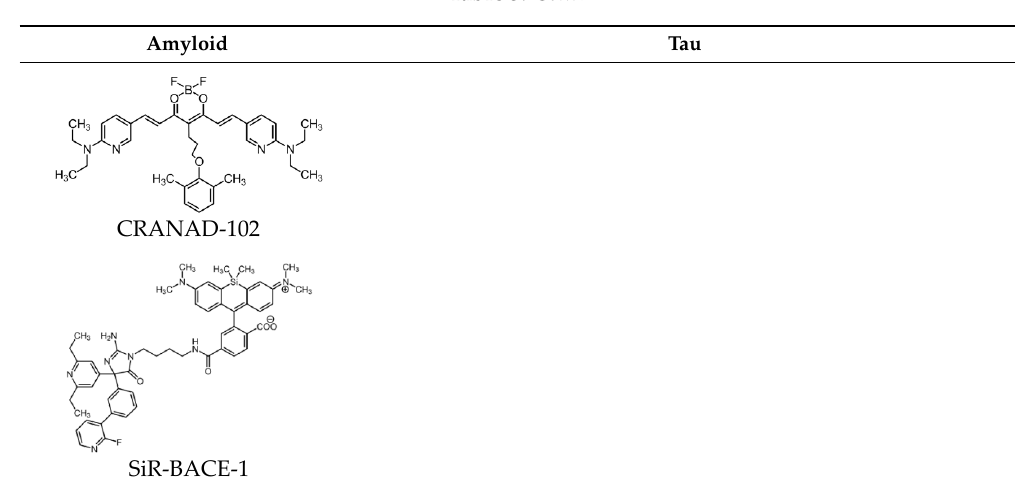
Figure 11. Ex vivo brain slices of tau transgenic mice labeled with the BD-tau and anti-tau paired helical filament (PHF) antibodies to demonstrate the accuracy of tau aggregates detection using BD- tau [105]. The third image is the overlay of the first two. Images are reprinted with permission of the publisher